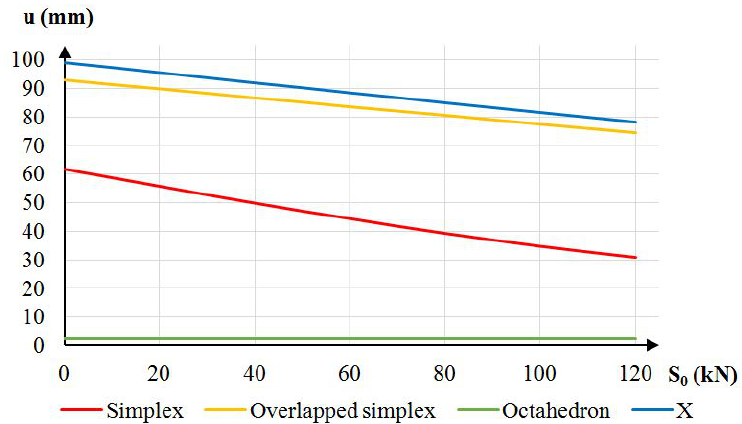
Figure 8. Deflection of the